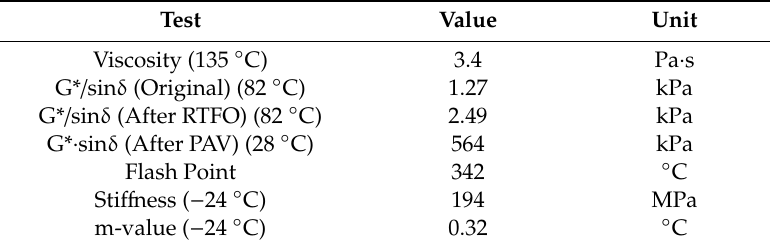
Table 1. Properties of asphalt binder PG82-34 [8].